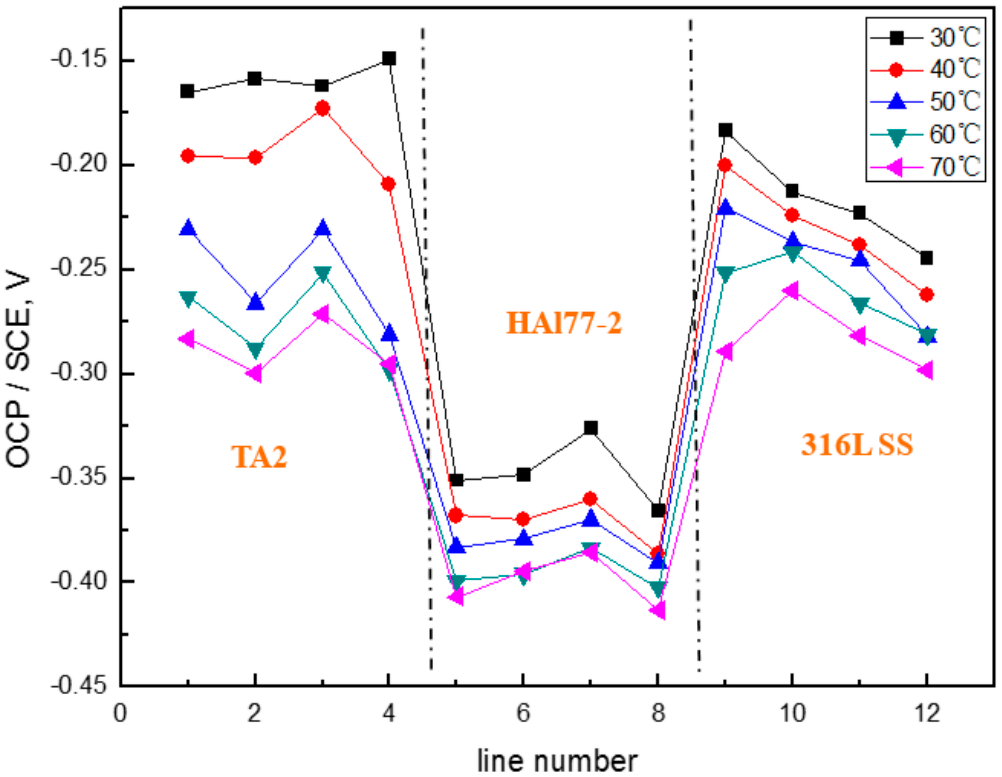
Figure 12. Average OCP distribution of each microelectrode line for WBE3 after immersion in artificial seawater at different temperatures.